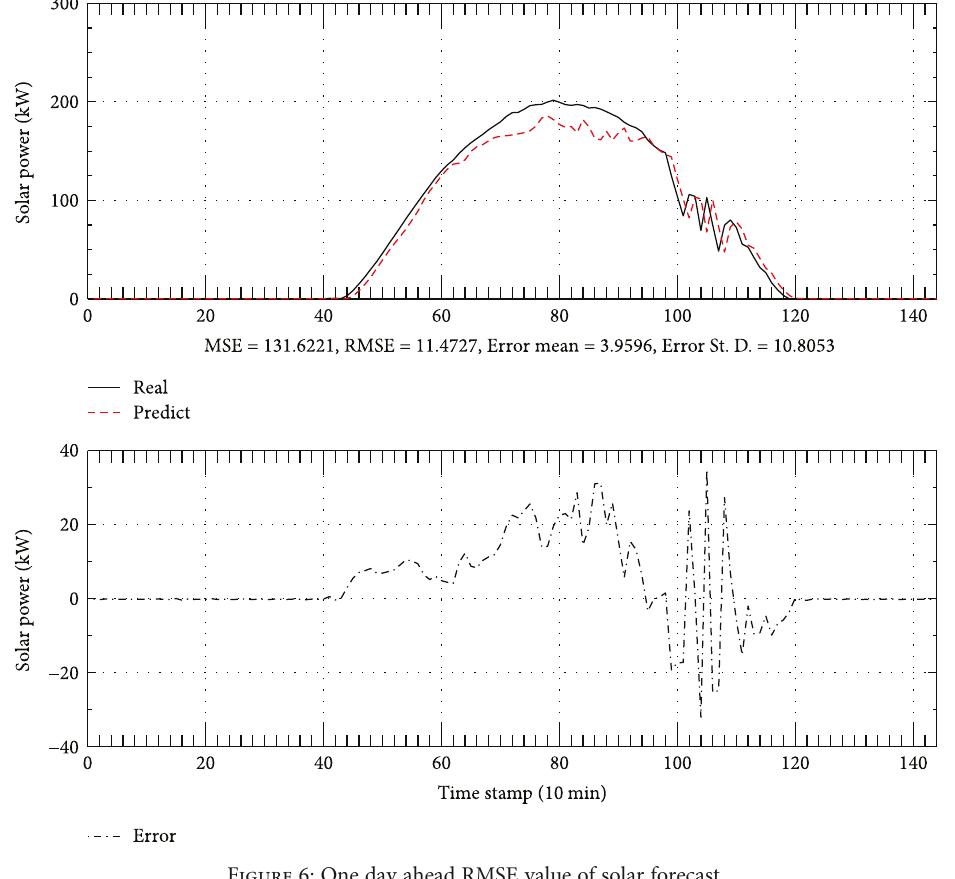
Figure 6: One day ahead RMSE value of solar forecast.